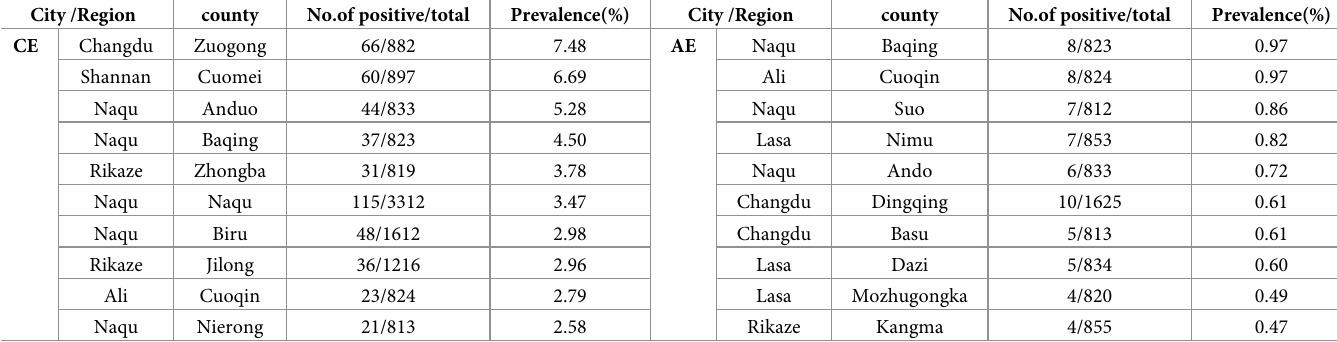
Table 3. Top 10 counties of Tibet in terms of prevalence for CE and AE. City